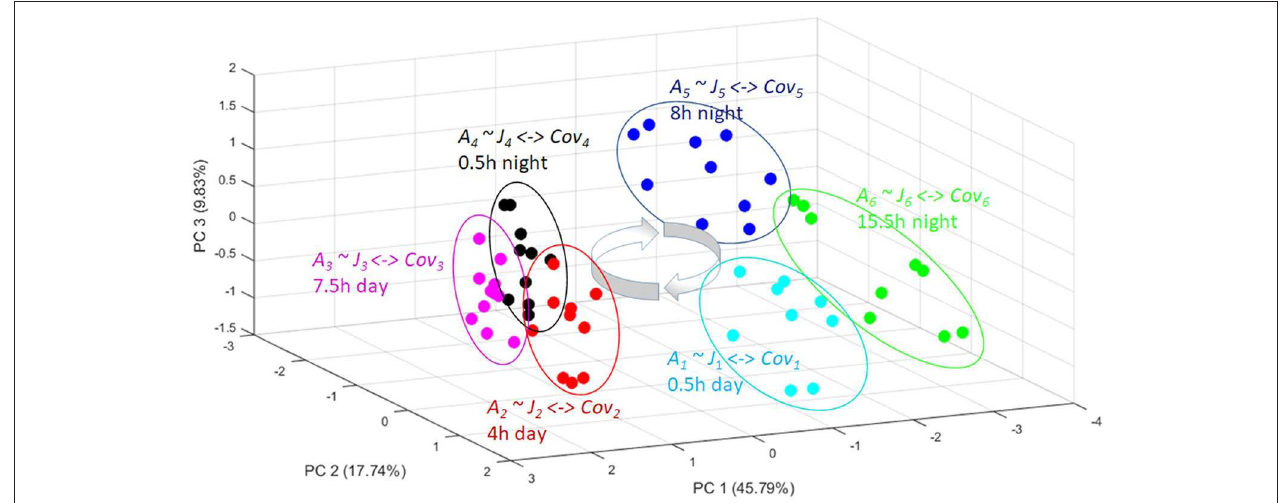
FIGURE 3 | A PCA plot showing the metabolomic trajectory of a diurnal cycle of Arabidopsis thaliana [37]. The independent biological replicates reach again and again the same quasi-steady state (the circles) in the phase space. From these replicate analysis a covariance matrix can be obtained for each time point (Cov 1 -Cov 6 ). From all these different covariance matrices a corresponding Jacobian (J 1 -J 6 ) can be calculated with the inverse stochastic Lyapunov matrix equation showing the biochemical perturbation and keypoints of control over a day-night cycle (for more details see